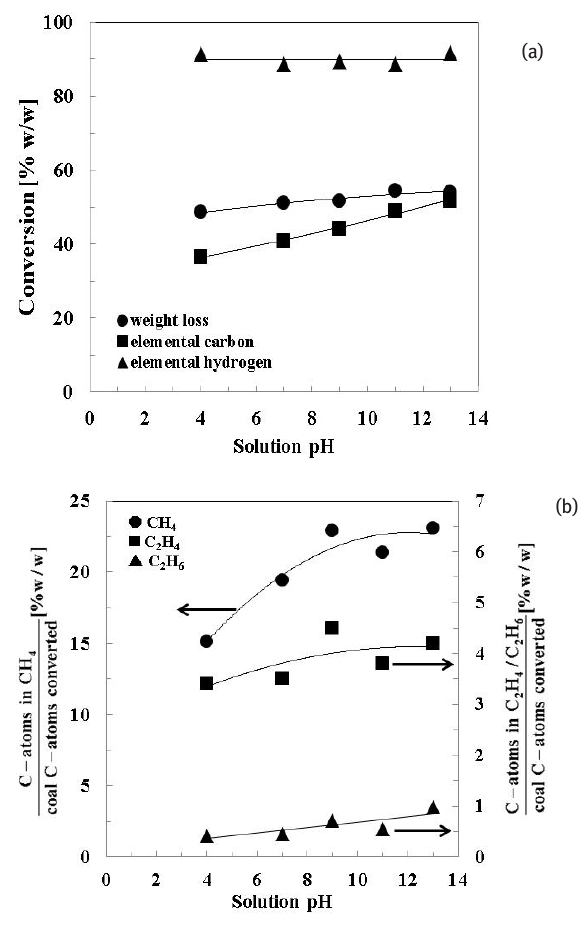
Figure 4: Effect of solution pH on (a) the weight loss and elemental carbon and hydrogen conversions and (b) on the